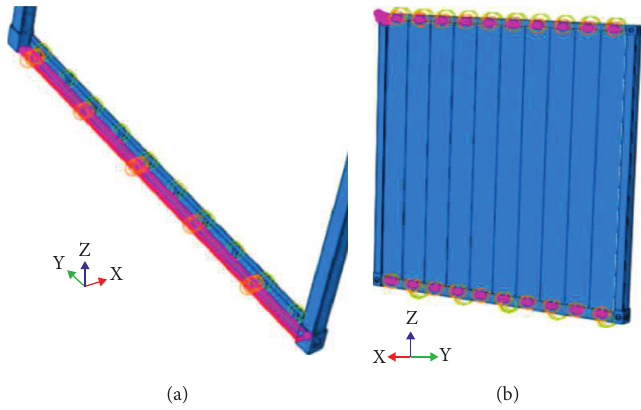
Figure 12: Binding forms of QY-1. (a) Surface binding of angle steel. (b) Point binding of bending plate.